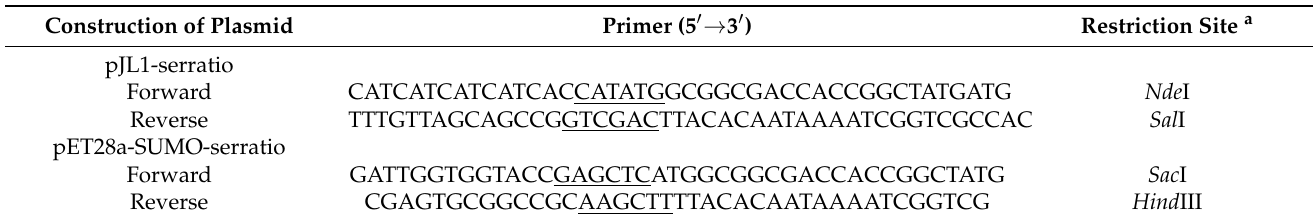
Table 1. Primers used for PCR amplification of the serratiopeptidase